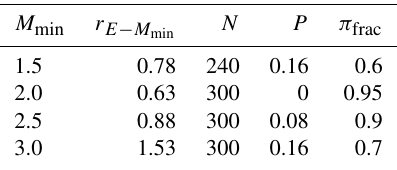
Figure 8. Frequency–magnitude distribution computed in one syn- thetic series as example. Each marker indicates different P values, P = 0 (dark blue circles), P = 0 . 08 (magenta squares), P = 0 . 16 (red triangles), P = 0.24 (black stars), P = 0 . 32 (green triangles), and P = 0 . 38 (turquoise circles). As P decreases, the distribution approaches a Gutenberg–Richter type relation (Eq. A7). Table 4. Minimum Euclidean distance r E − M (Eq. 7) using four min different M min NOR series (Table 3).